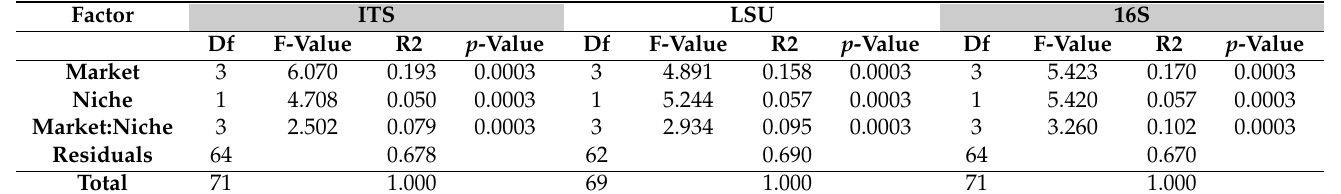
Table 1. Results from permutational multivariate analysis of variance (PERMANOVA) of ITS, LSU and 16S rDNA for market (Ciba, Longjin, Wanyao, New District) and tofu niche (inside vs. outside of the tofu sample) as well as their interaction (market:niche) are shown. All p -values were adjusted using the Bonferroni